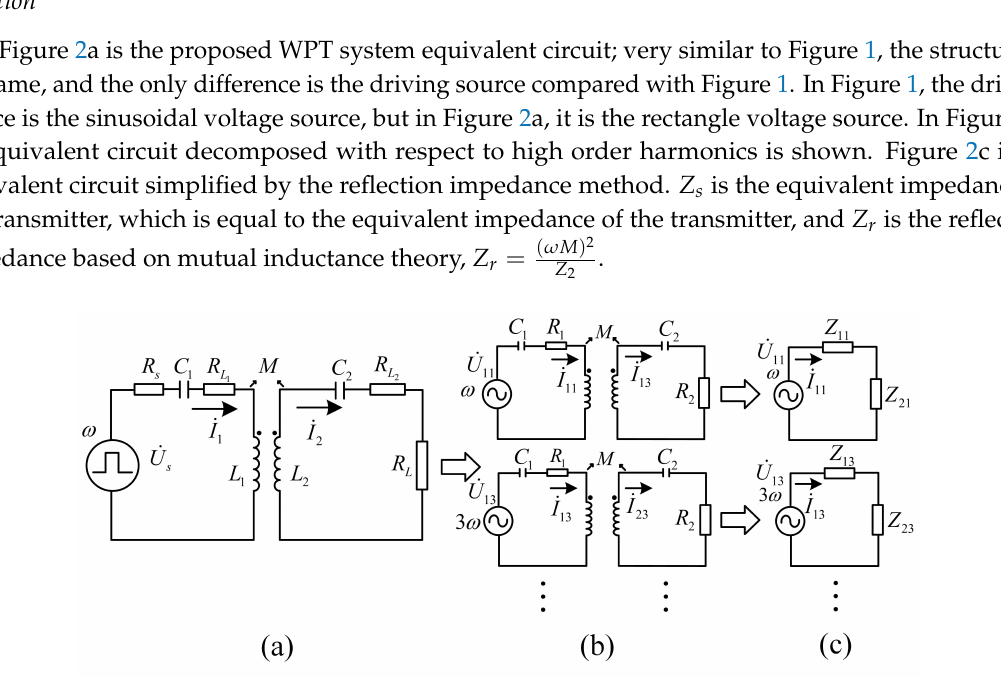
Figure 2. Decomposition diagram for the circuit with the harmonics components. ( a ) Equivalent circuit with rectangle power source; ( b ) decomposed circuit; ( c ) circuit represented using reflection